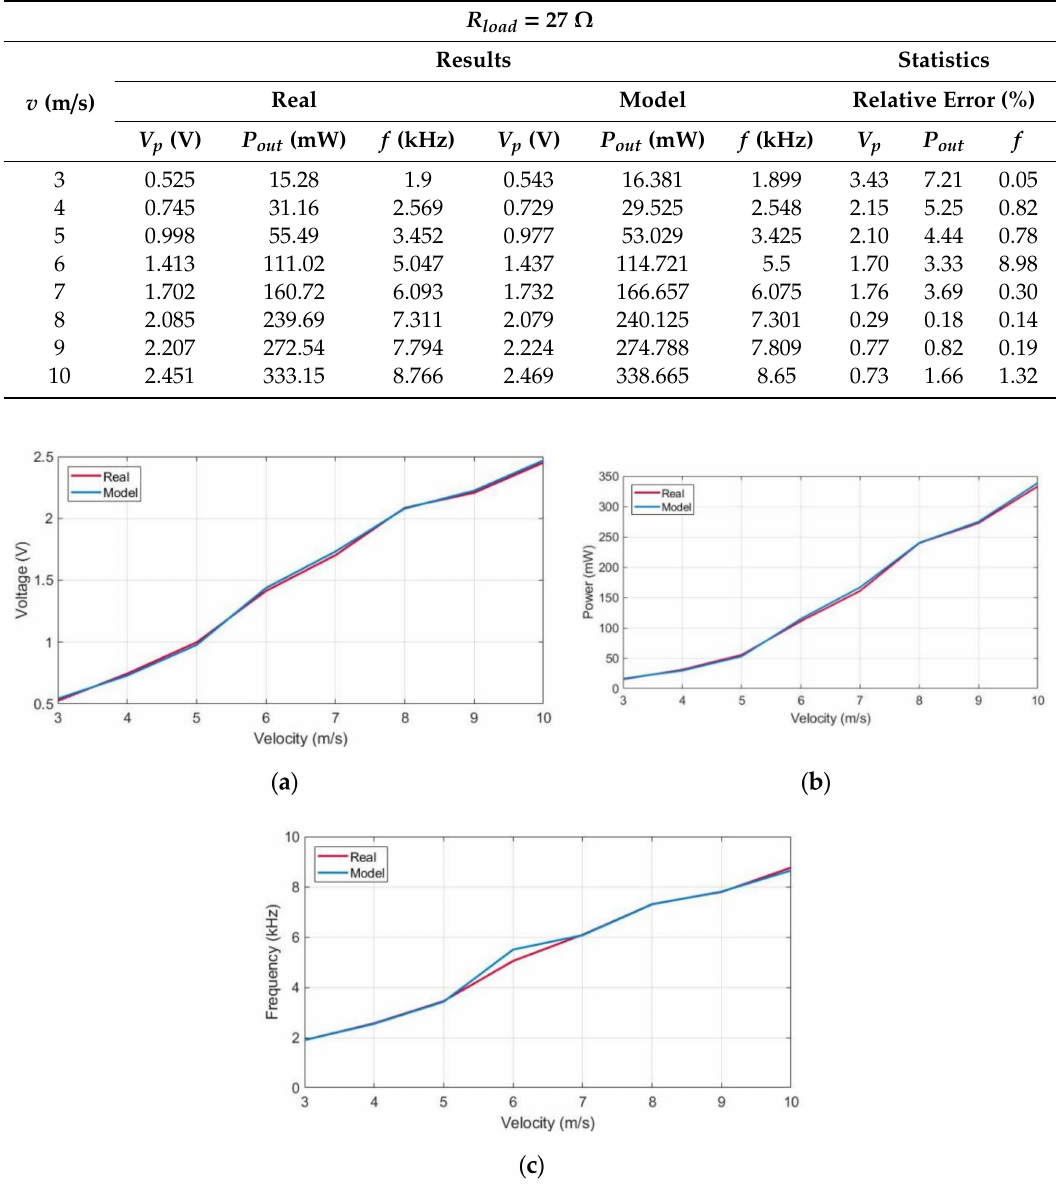
Table 16. Comparison of results between the real measurements and model simulation under di ff erent wind conditions with a load impedance matching condition.